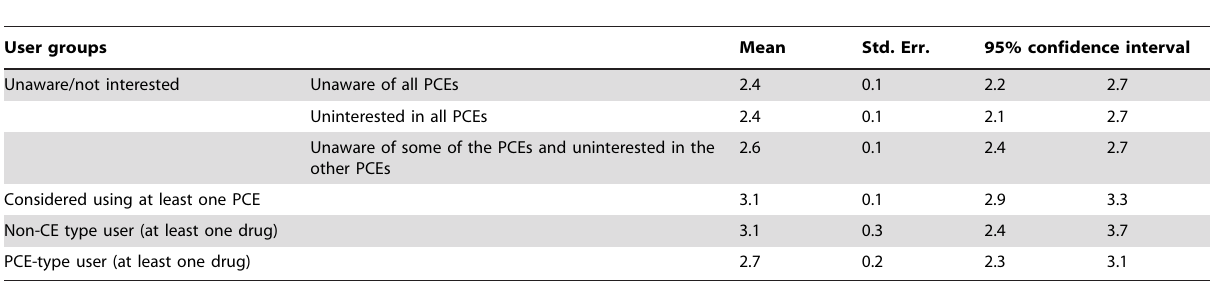
Table 6. ADHD ASRS Score by user group, n